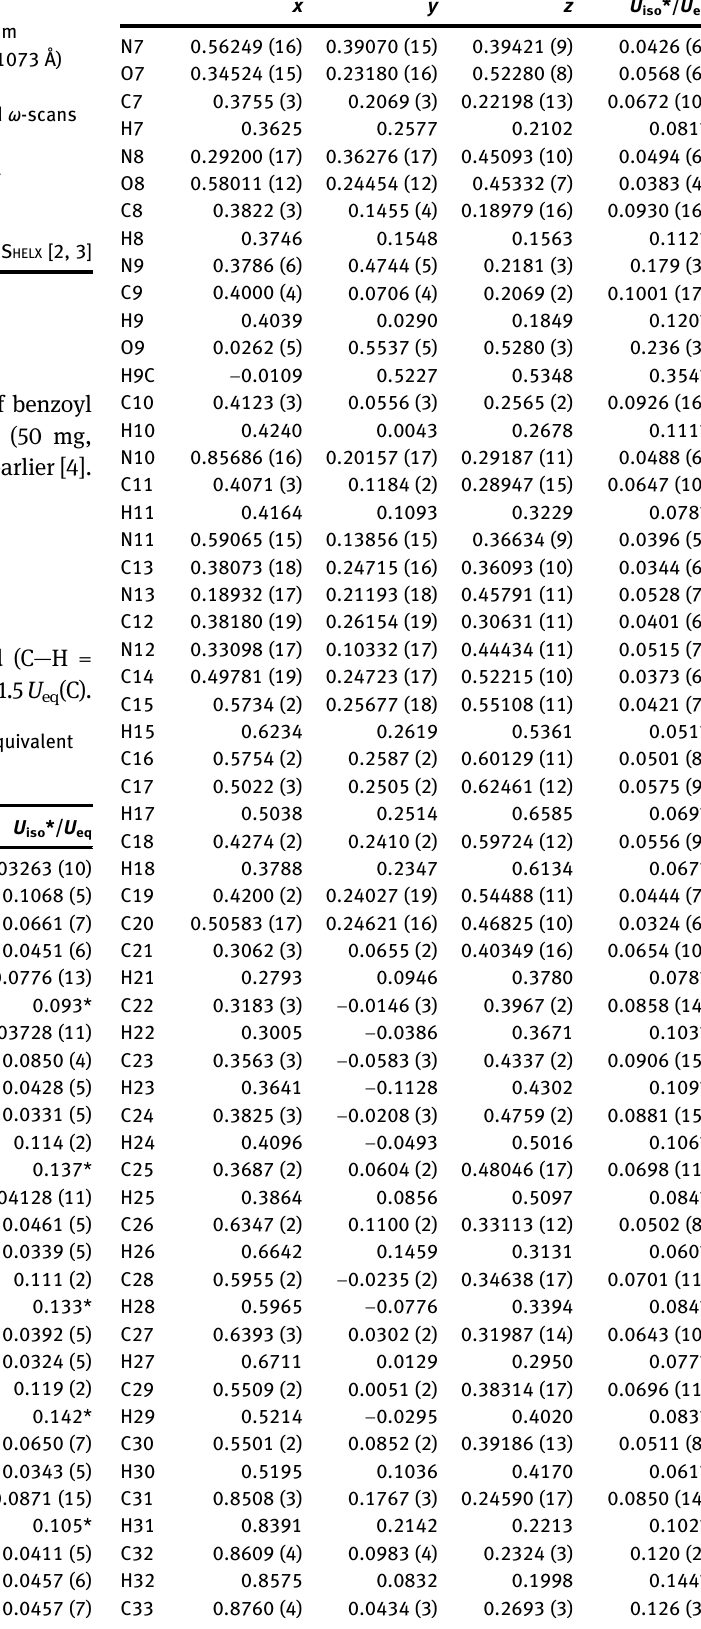
Diffractometer, scan mode: Bruker APEX-II, φ and ω -scans θ max ,